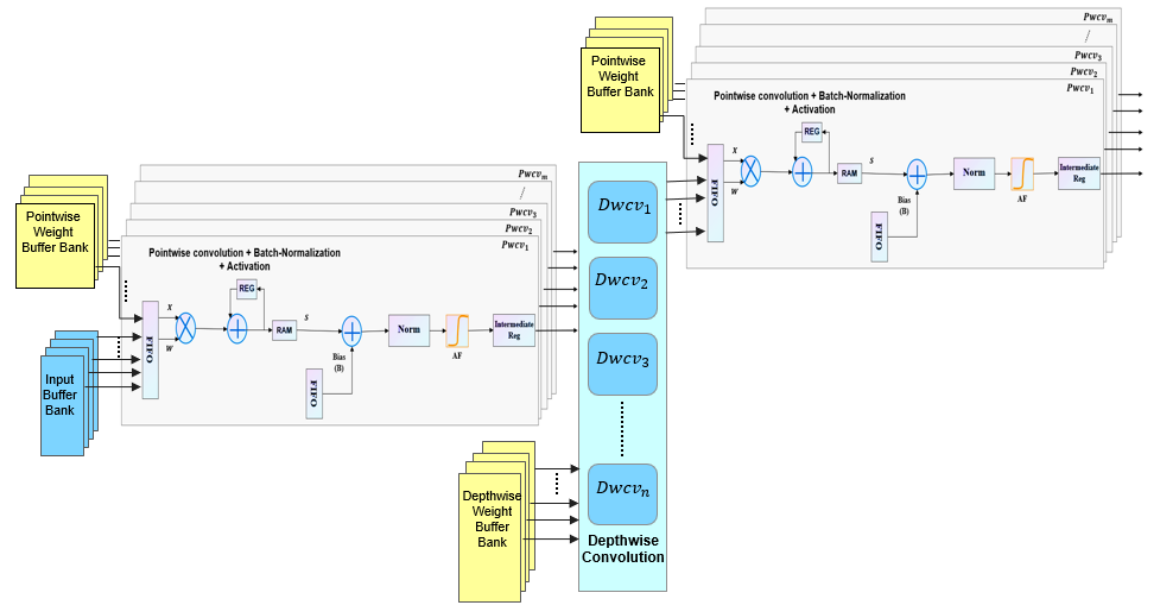
Figure 15. Hardware architecture of the Ad-depth